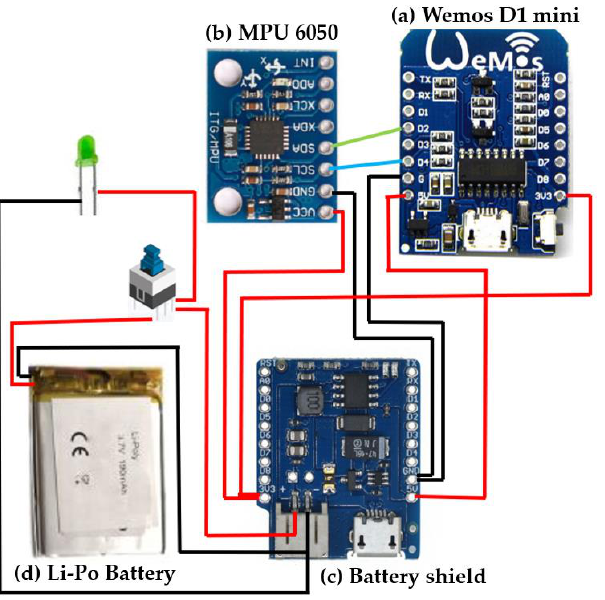
Figure 9. Wemos D1 mini Wi-Fi board ( a ),GY 521 MPU 6050 ( b ), battery shield ( c ) and Li-Po battery motion sensor connection diagram ( d